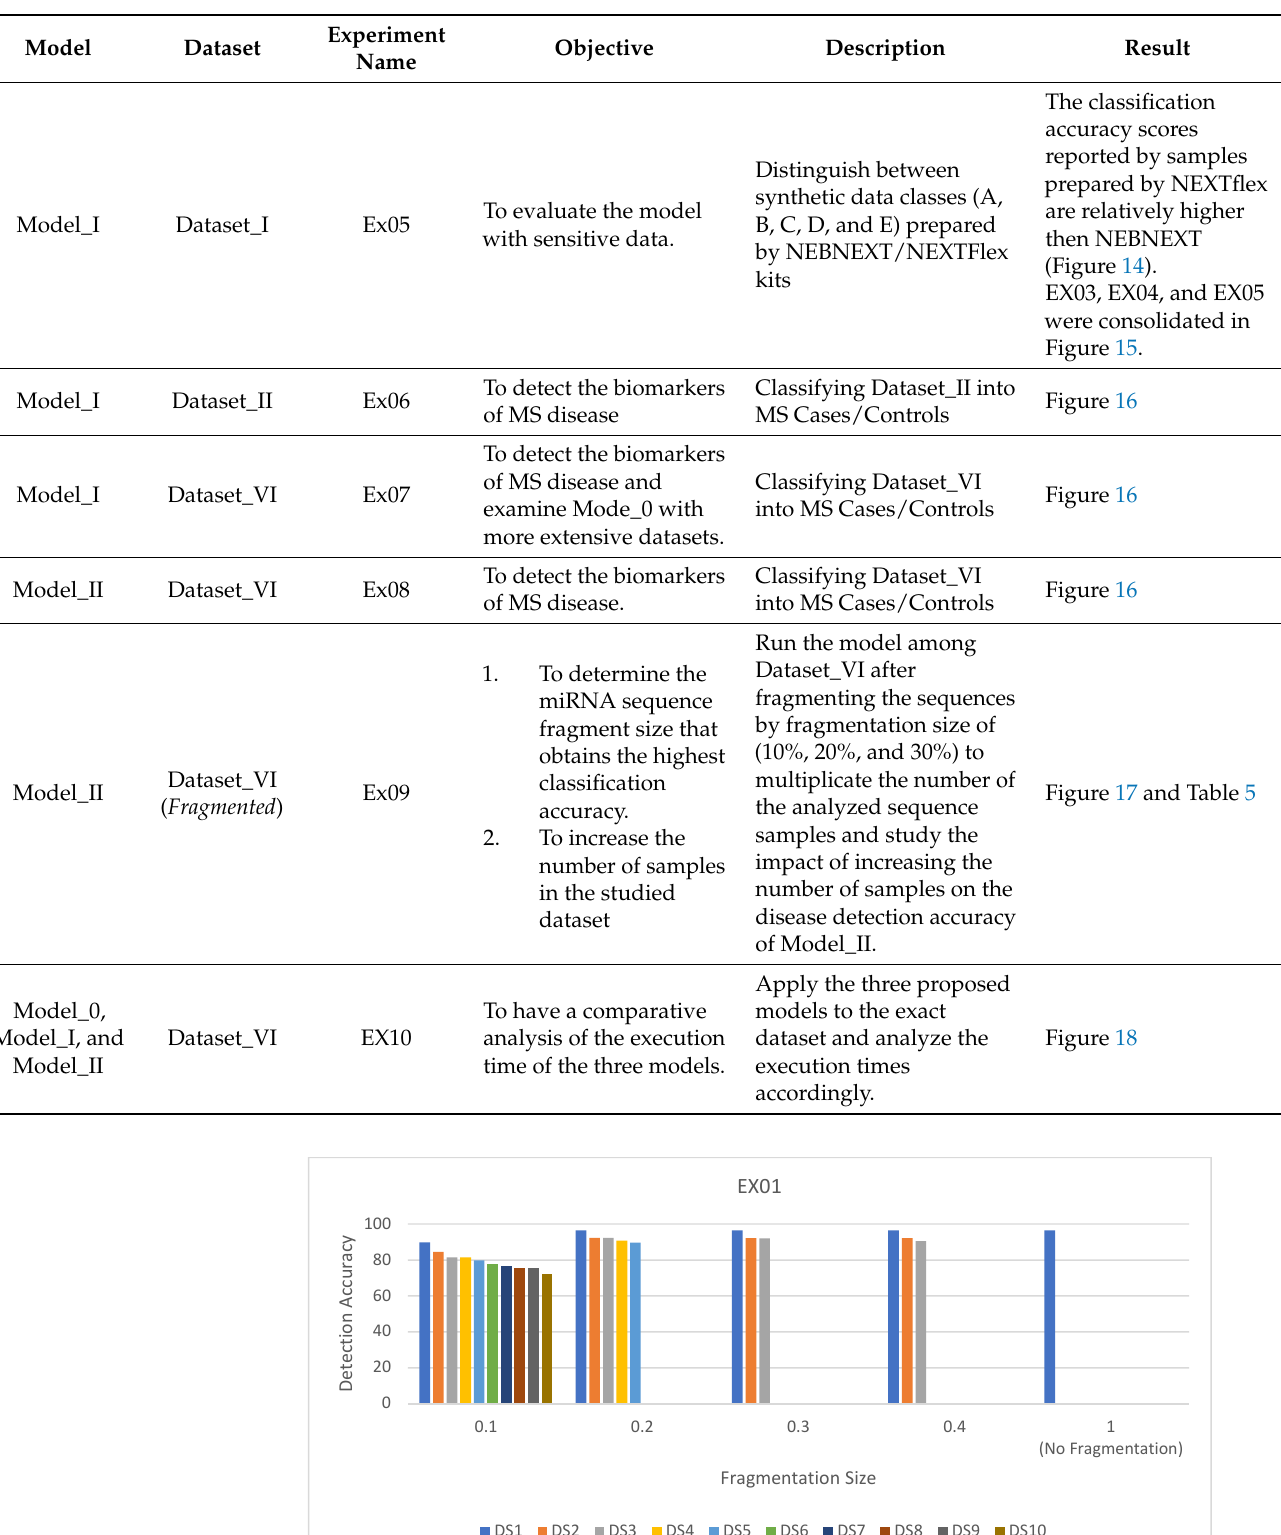
Figure 10. The reported accuracy scores upon sequence fragmentation (f = 0.1, 0.2, 0.3, 0.4, 1) of applying Model_I to Dataset_VI (EX01). Figure 11. The reported accuracy scores of biomarker detection upon sequence fragmentation (f = 0.1, 0.2, 0.3, 0.4, 1) using Model_I and Dataset_I (EX02).